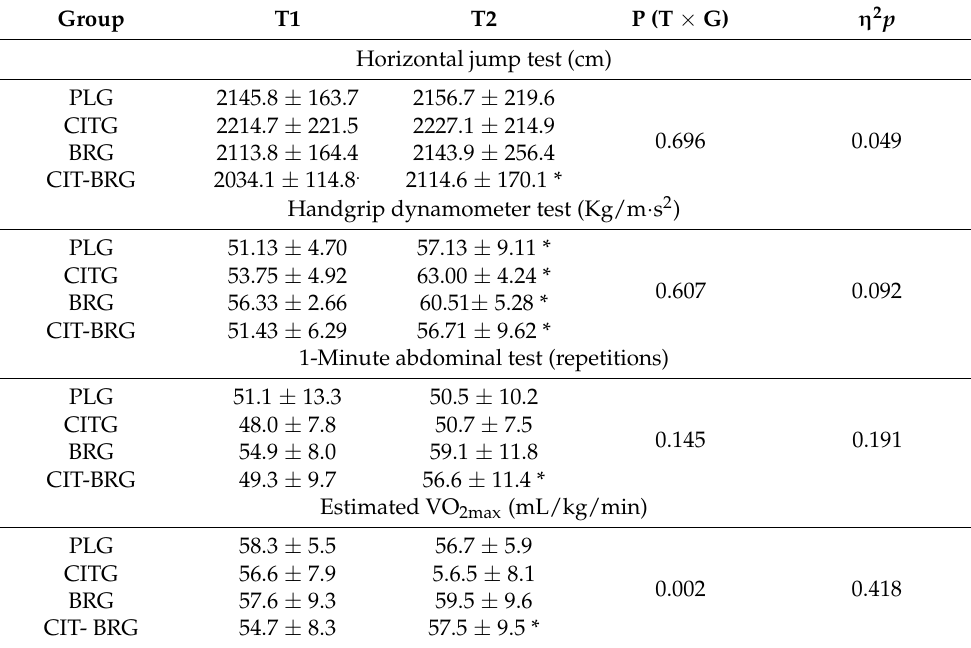
Table 2. Maximal strength, endurance-strength, and aerobic power in the four study groups at baseline (T1) and after 9 weeks (T2).